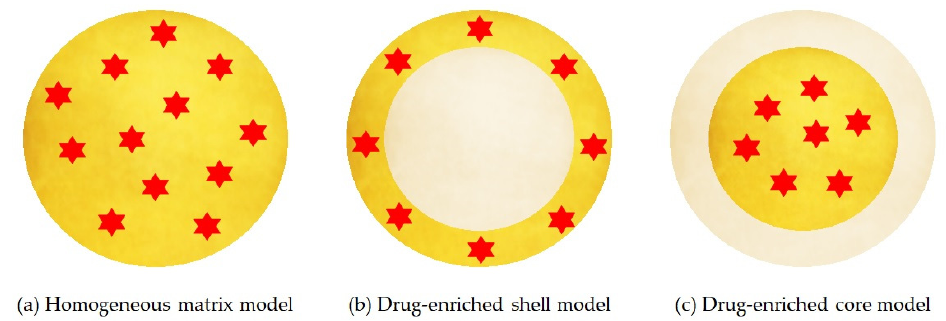
Figure 4. Three models of SLN drug incorporation: ( a ) homogeneous matrix model, ( b ) drug-enriched shell model, ( c ) drug enriched core model. Red color indicates the active compound encapsulated, yellow and grey color refer to lipid phases with and without dispersed drug, respectively. Adapted from [63], Müller, R. H., 2000.